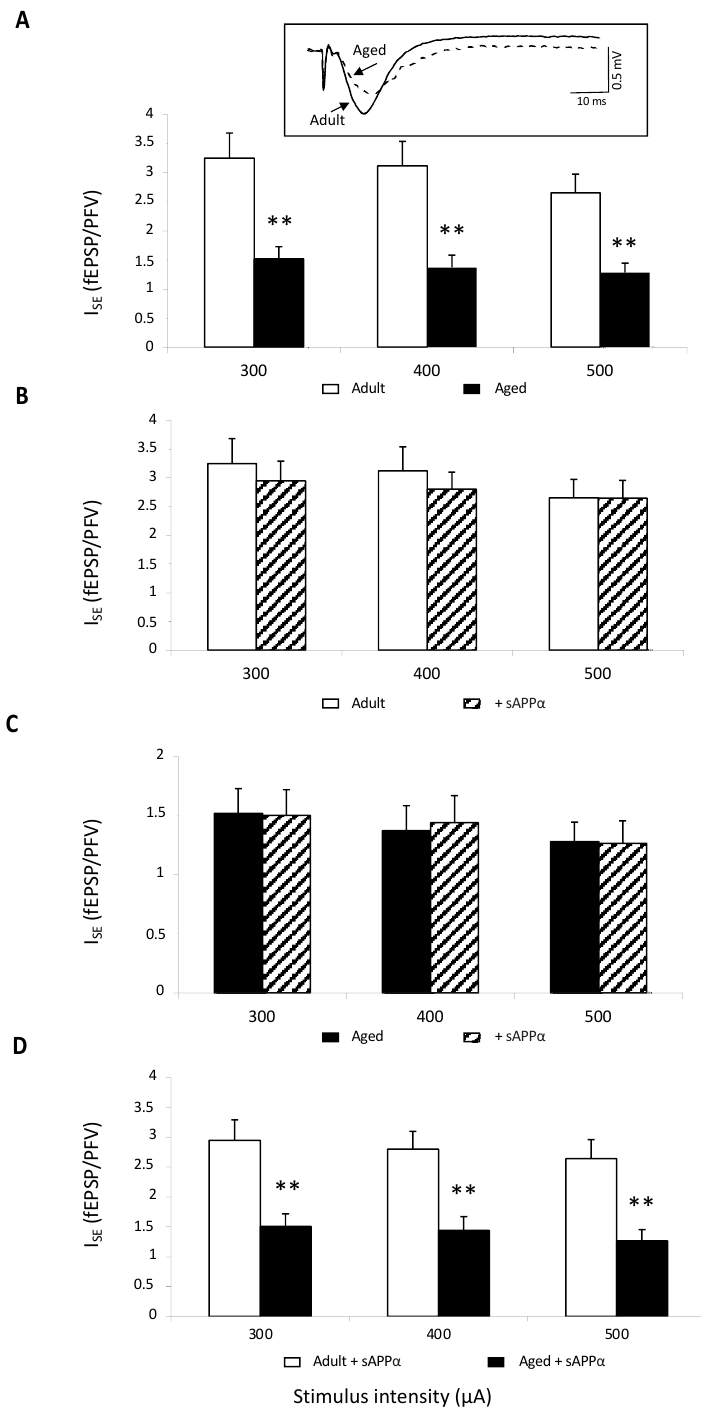
Figure 3. Basal neurotransmission is not affected by sAPP α . ( A ) Comparison of the index of synaptic efficacy (I SE ) corresponding to the fEPSP/PFV slope ratio of non-NMDAR-mediated synaptic potentials plotted against current intensity in adult (12 slices/7 mice) and aged animals (11 slices/8 mice) (** for p < 0.01 compared to adult mice one-way ANOVA). In the insert are superim- posed representative traces of non-NMDAR-mediated fEPSPs obtained at 400 µ A stimulation intensity. ( B ) Bar graphs illustrating the effects of sAPP α (0.1 nM) on I SE of nonNMDAR-mediated fEPSPs in adult mice. ( C ) Bar graphs illustrating the effects of sAPP α (0.1 nM) on I SE of non-NMDAR-mediated fEPSPs in aged mice. ( D ) Comparison of the I SE calculated in slices from adult and aged mice plotted against current intensity in sAPP α -supplemented aCSF (** for p < 0.001 compared to adult mice one-way